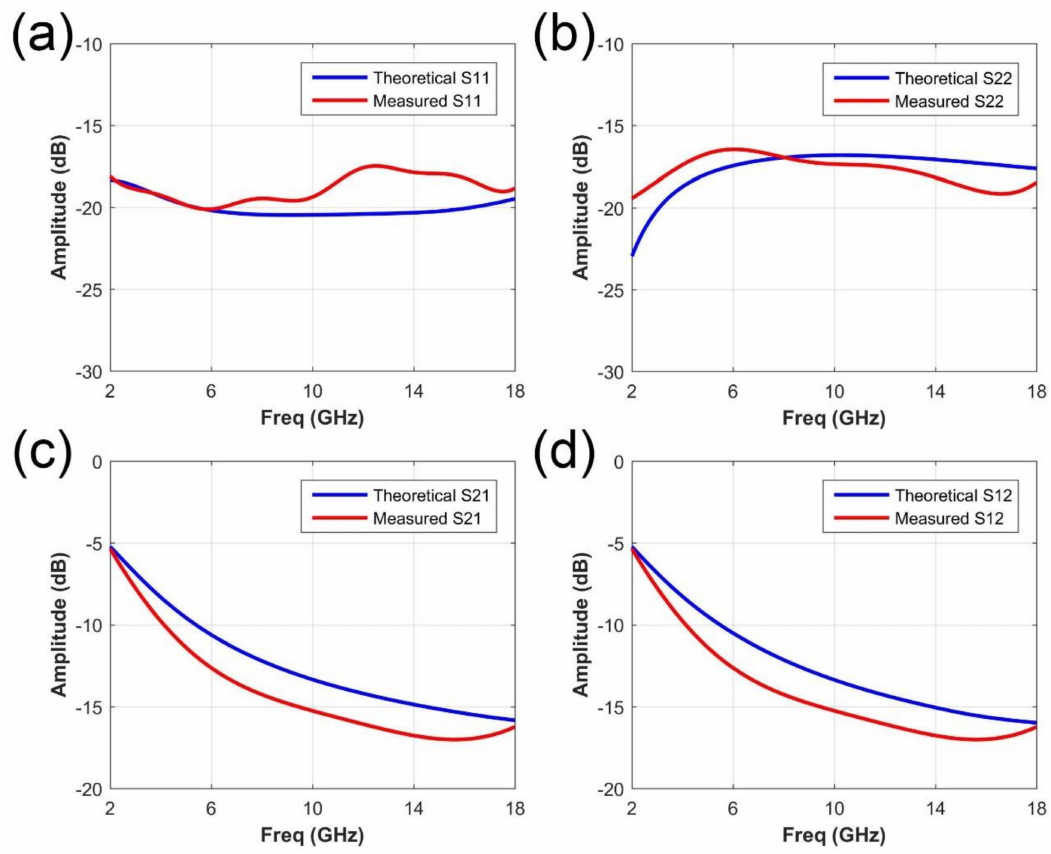
Figure 7. The measured reflection and transmission coe ffi cients of the presented metasurface. ( a , b ) The reflection coe ffi cients of two ports, S11 and S22, measured in the experiments. ( c , d ) The transmission coe ffi cients, S21 and S12, measured in the